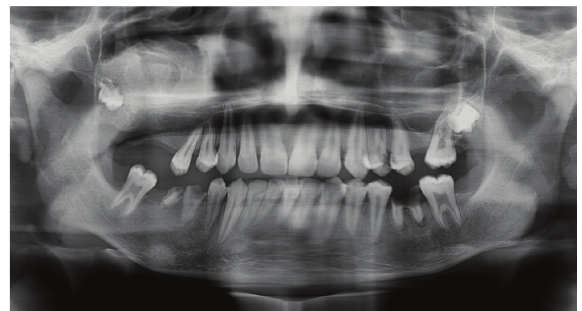
Figure 10: Postoperative radiograph showing signs of calcification in maxilla and